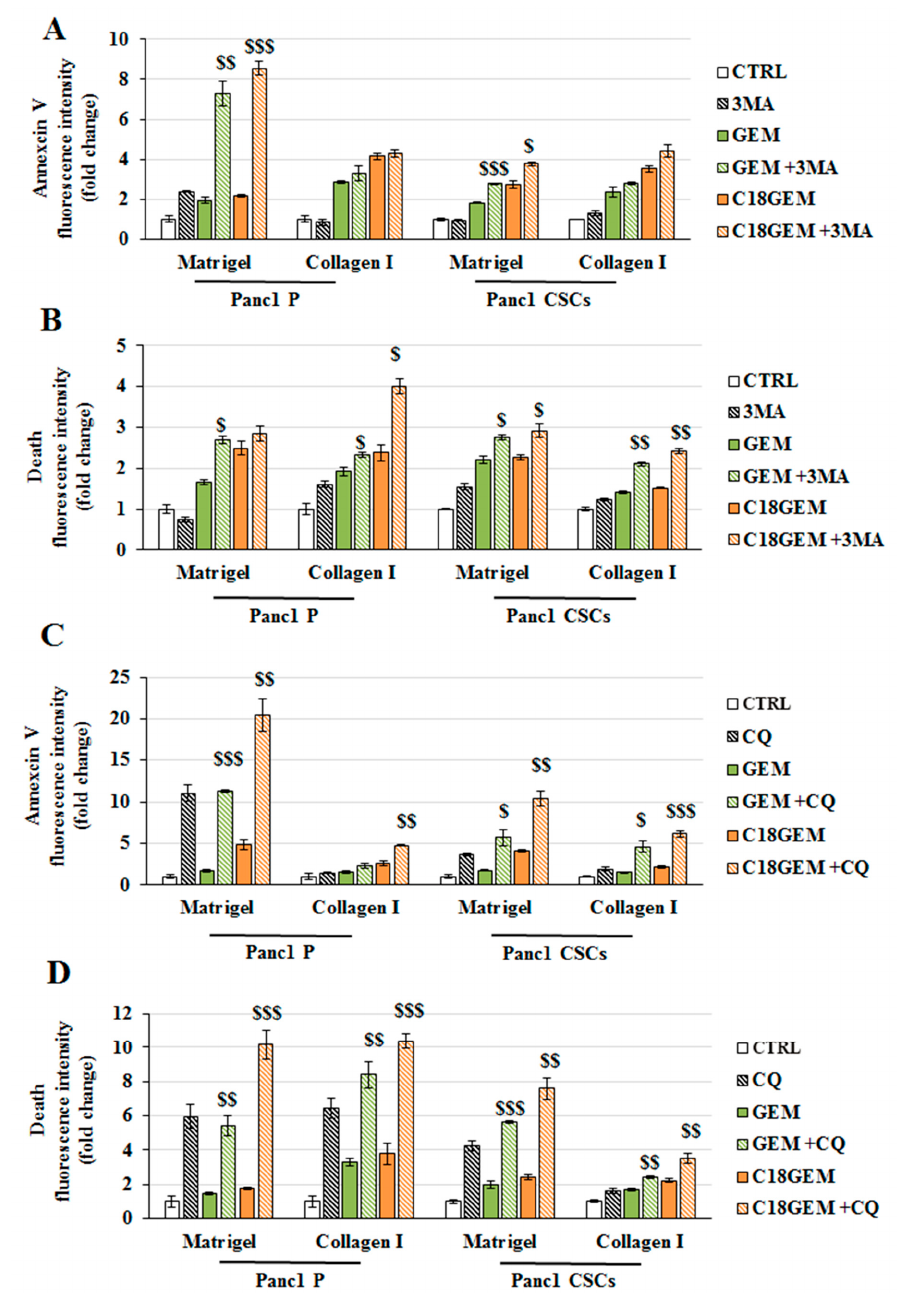
Figure 7. Autophagy inhibition sensitizes Panc1 parental and CSCs growing on different ECM compositions to both GEM and C18GEM treatment. Annexin V ( A ) and ethidium homodimer ( B ) fluorescence intensity of parental (P) cells and CSCs treated with 50 µ M of GEM or C18GEM for 72 h in Matrigel- and collagen I-rich ECM in the absence or presence of 3 mM 3-MA, an autophagy inhibitor. Annexin V ( C ) and ethidium homodimer ( D ) fluorescence intensity of parental (P) cells and CSCs treated with 50 µ M of GEM or C18GEM for 72 h in Matrigel- and collagen I-rich ECM in the absence or presence of 100 µ M CQ. The values are reported as fold change relative to untreated cells and are the means ( ± SE) of at least three independent biological replicates. Statistical legend: p < 0.05 ($), p < 0.01 ($$), or p < 0.001 ($$$) GEM or C18GEM versus GEM+3-MA or